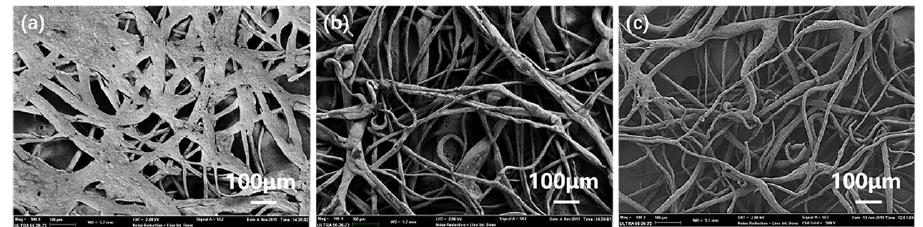
Figure 5. SEM of high-load-modified MMT composite fiber membrane: ( a ) 4 wt% HCl-MMT; ( b ) 5 wt% SDS-MMT; ( c ) 6 wt% CTS-MMT.